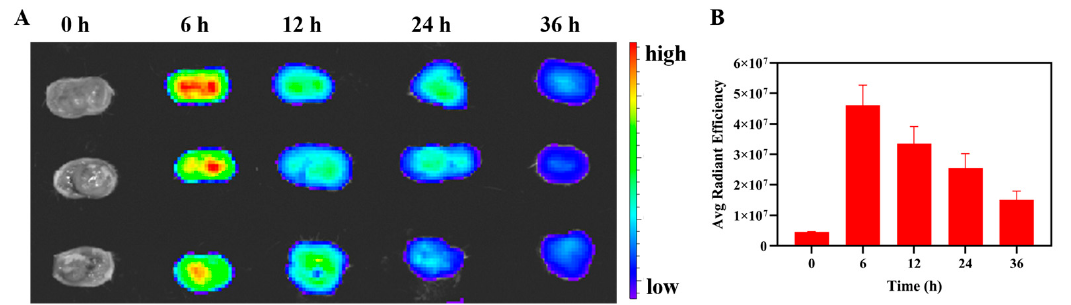
Figure 5. ( A ) Ex vivo fluorescence imaging of tumors at different time points after injection of ICG&DHA@ZIF-8 by tail vein. ( B ) Average radiant efficiency fluorescence values of tumors ( n = 3).